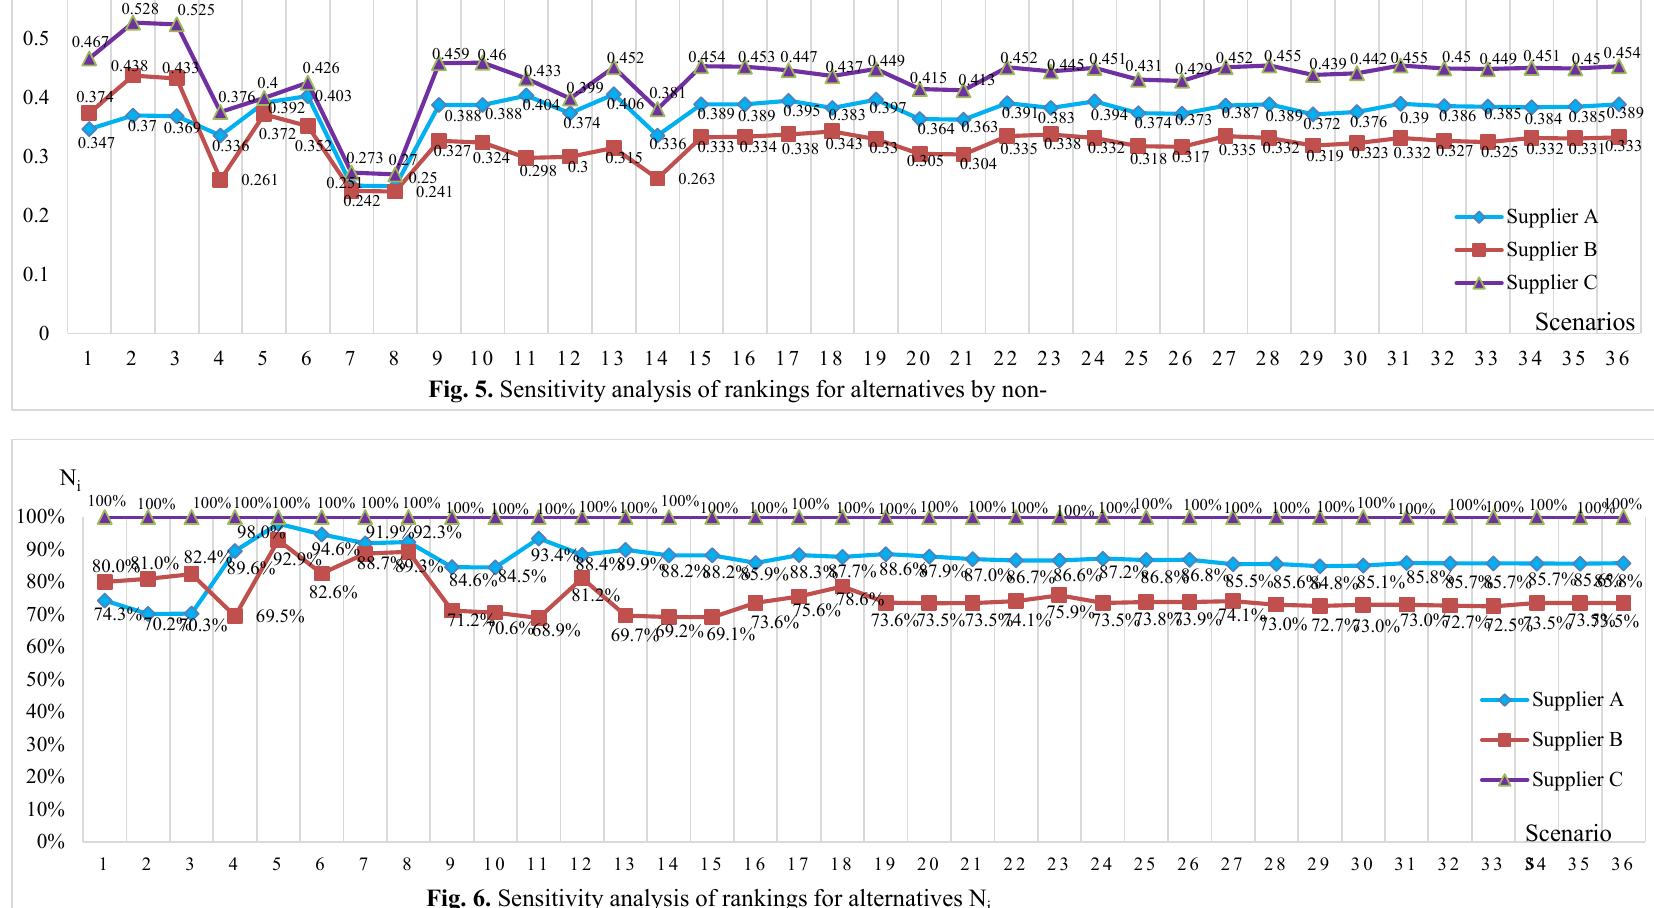
Fig. 6. Sensitivity analysis of rankings for alternatives N